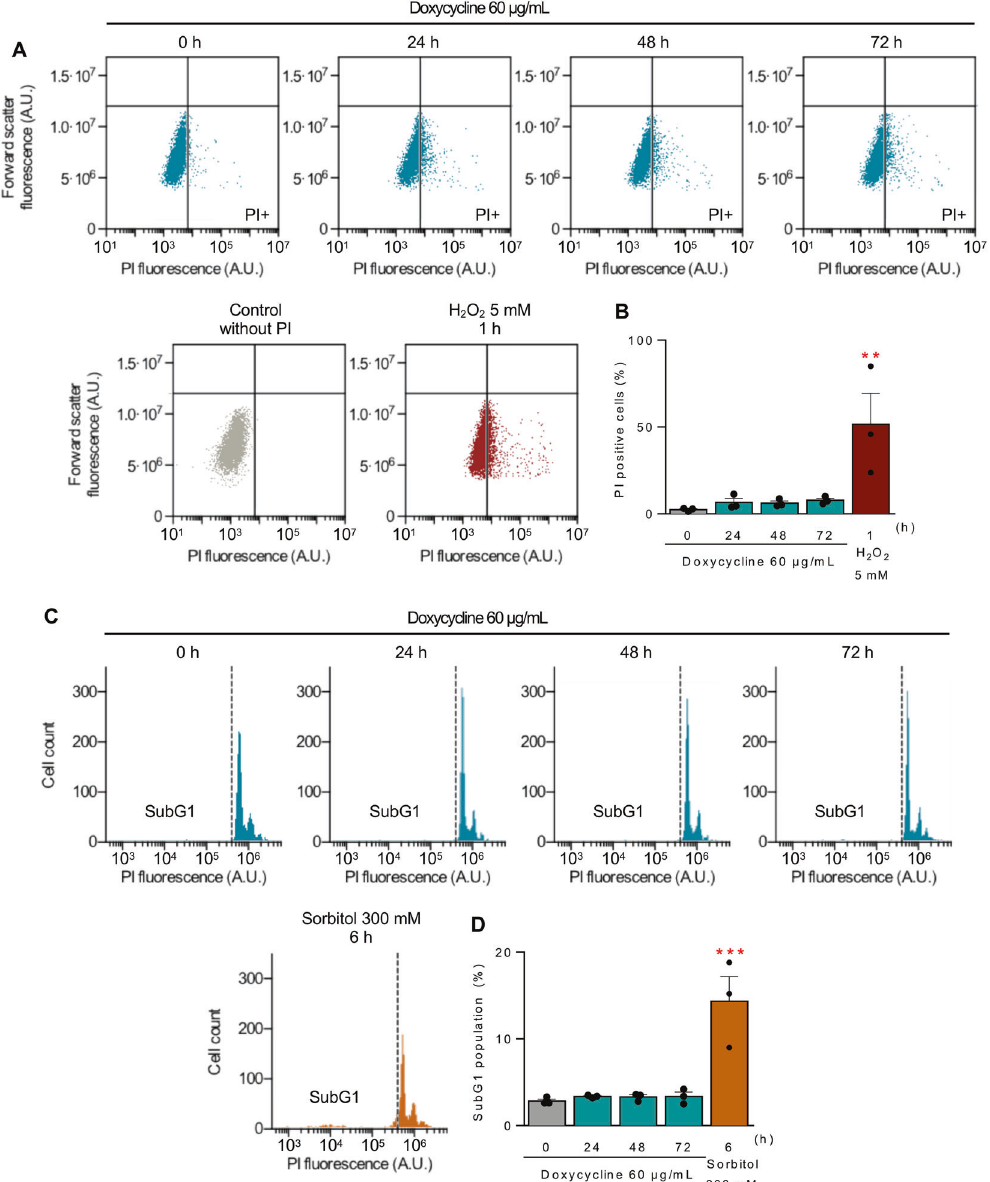
Fig. 7 Doxycycline does not induce cell death. A , B HeLa cells were treated with 60 µg/mL doxycycline for the indicated times. Total cell death was measured as the incorporation of PI in non-permeabilized cells by fl ow cytometry. A Representative plots of relative cell size